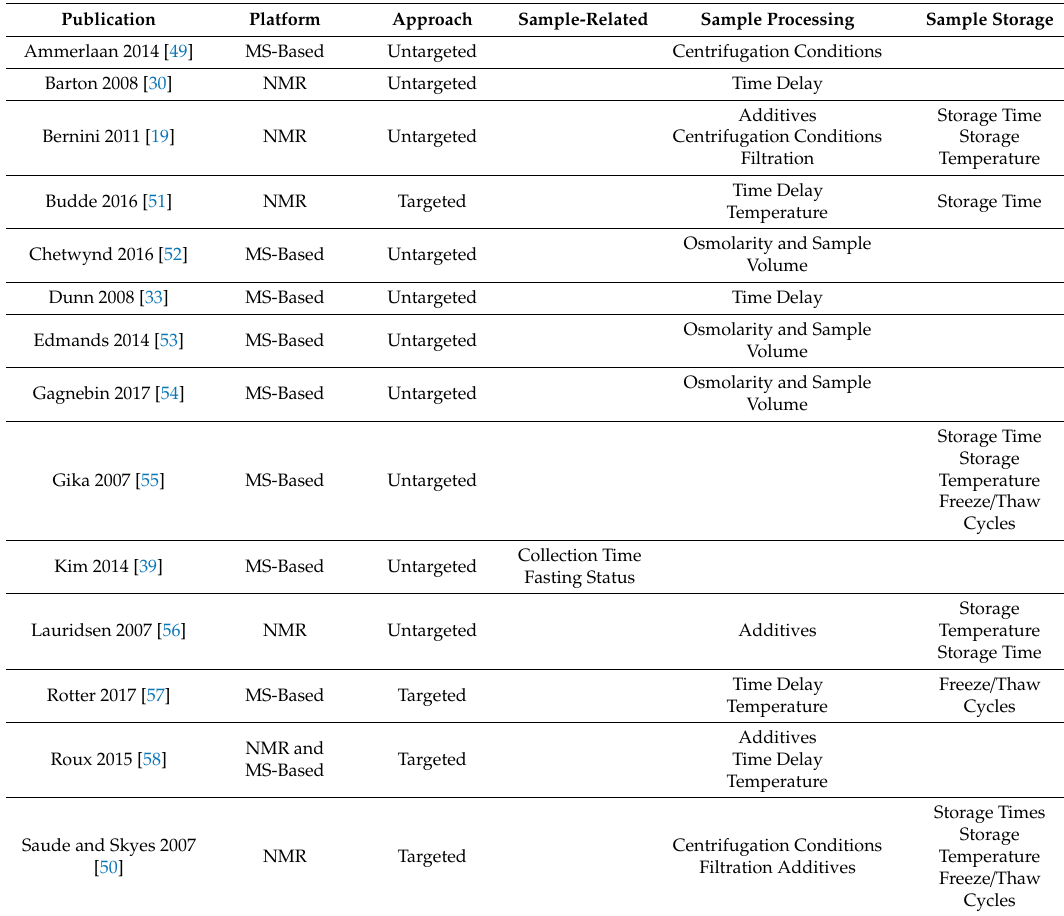
Table 2. Studies of pre-analytical factors that influence metabolomic studies conducted with